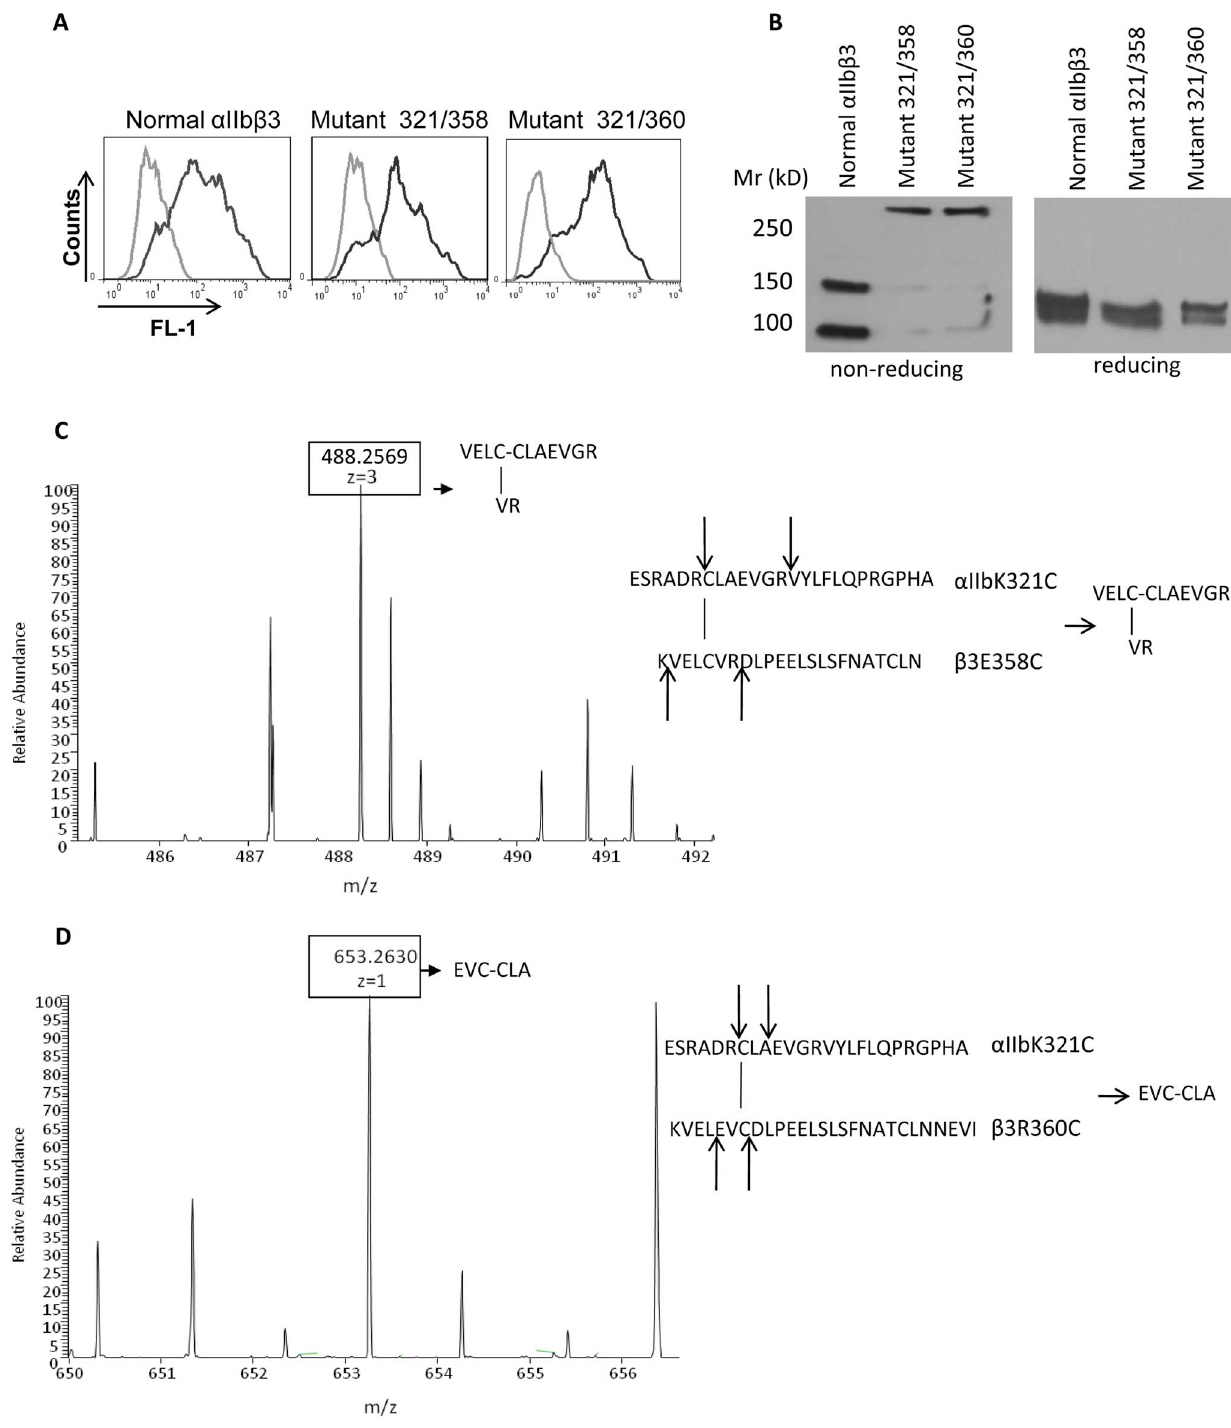
Figure 2. Analysis of mutant protein expression. A. Surface expression of a IIb b 3 on HEK293 cells expressing normal or mutant a IIb b 3 receptors as judged by the binding of mAb 10E5. 1 million cells in 100 m l were incubated with 5 m g/ml Alexa488-conjugated mAb 10E5 (black line) or as a control for non-specific binding, 5 m g/ml Alexa488-conjugated mAb 10E5 in the presence of excess (125 m g/ml) unlabelled 10E5 (gray line; background). B. Disulfide-bonded a IIb b 3 heterodimer formation on the cell surface of XS-O mutants. HEK293 cells expressing normal a IIb b 3 or XS-O mutants were biotinylated and lysed, and lysates were immunoprecipitated with anti- a IIb b 3 complex mAb 10E5. After SDS- PAGE and protein transfer, biotinylated proteins were identified with streptavidin-HRP. Left panel. Non-reduced SDS-PAGE analysis of normal a IIb b 3 and XS-O mutants. Right panel. SDS-PAGE analysis of normal a IIb b 3 and XS-O mutants under reducing conditions (10% b -mercaptoethanol). C and D. Mass spectroscopy identifies unique, predicted peptides from XS-O mutants. C. Purified protein from mutant 321/358 was digested with trypsin and analyzed by LC-MS/MS. A peak at m/z=488.2569 corresponded to the predicted disulfide linked MH 43 + ion of peptide VELC(-VR)- CLAEVGR. D. Purified protein from mutant 321/360 was digested with trypsin and ASP-N, followed by LC-MS/MS analysis. A peak at m/z=653.2639 corresponded to the predicted disulfide linked MH 4 + ion of EVC-CLA. doi:10.1371/journal.pone.0081609.g002 PLOS ONE |